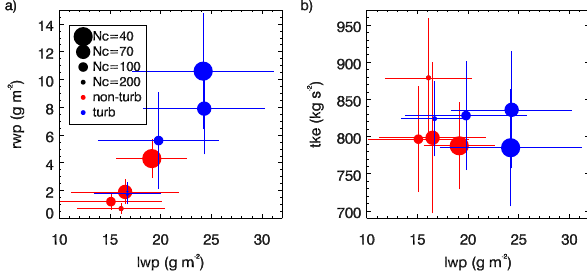
Figure 11. Average RICO cloud and dynamical properties for specified CDNC. Liquid water path (gm − 2 ) and (a) rain water path (gm − 2 ) , and (b) vertically integrated turbulent kinetic energy (kgs − 2 ) . The length of the bars denote the ± standard deviations about the